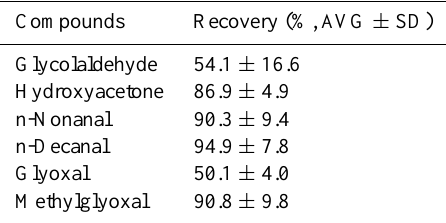
Table 2. Recoveries (%) of authentic carbonyls from quartz